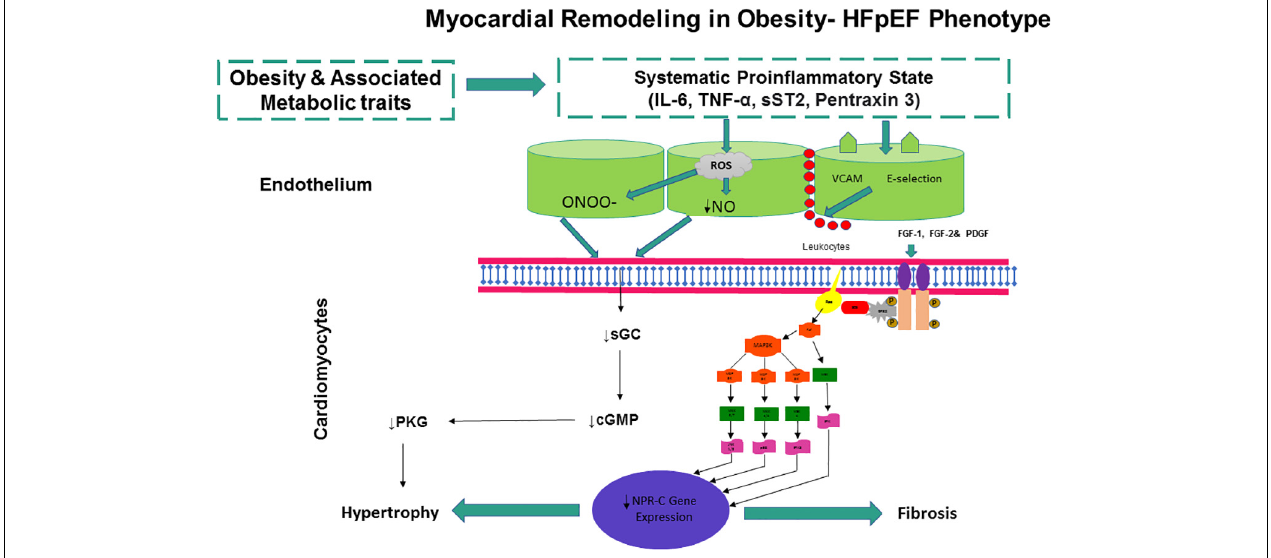
FIGURE 1 | The NPR-C pathway. NPs bind to NPR-C, which is also considered a clearance receptor responsible for receptor-mediated NP degradation. Recent evidence suggests that NPR-C may be coupled to inhibition of adenylyl cyclase (AC) through G i protein or activation of phospholipase C (PLC) through G i protein. Inhibition of PLC activity may result in decreased production of diacylglycerol (DAG) and inositol triphosphate (IP 3 ). NPR-C activation may also have some antiproliferative